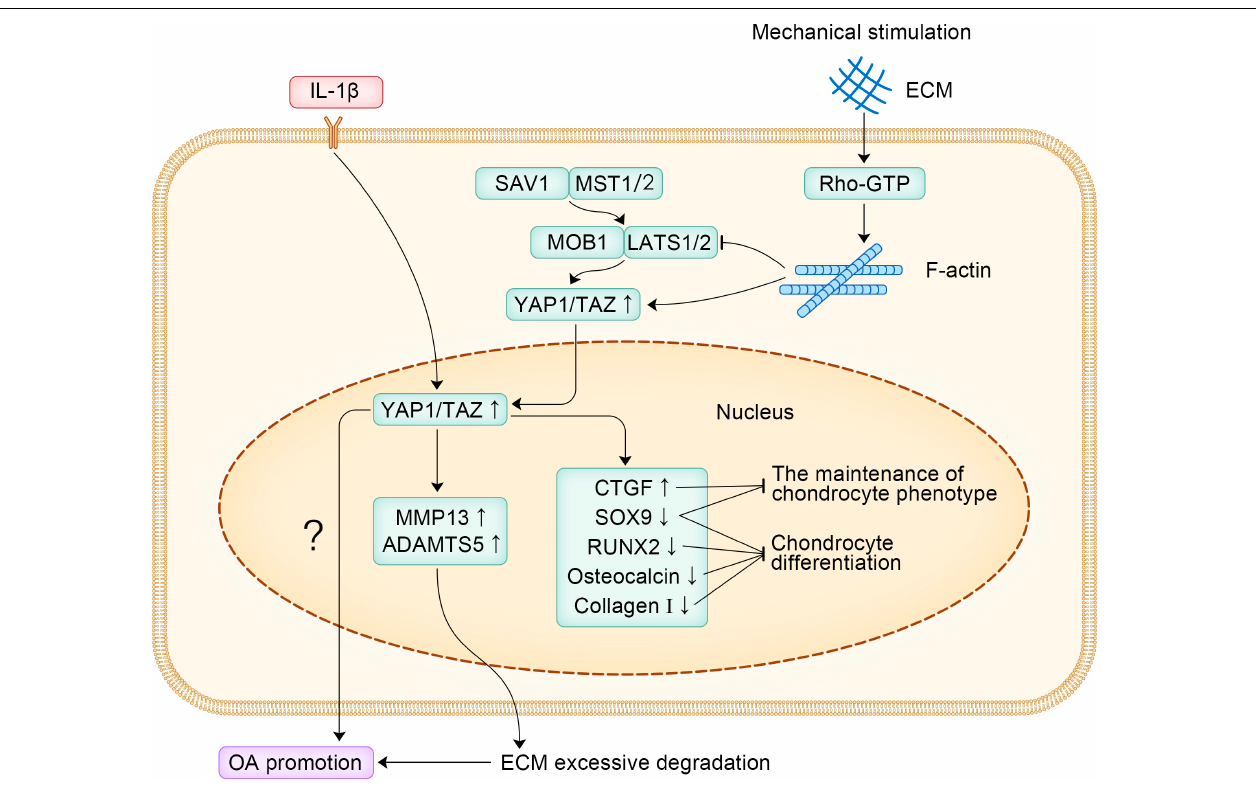
FIGURE 2 | The specific signaling pathways of YAP1 promoting the occurrence and development of